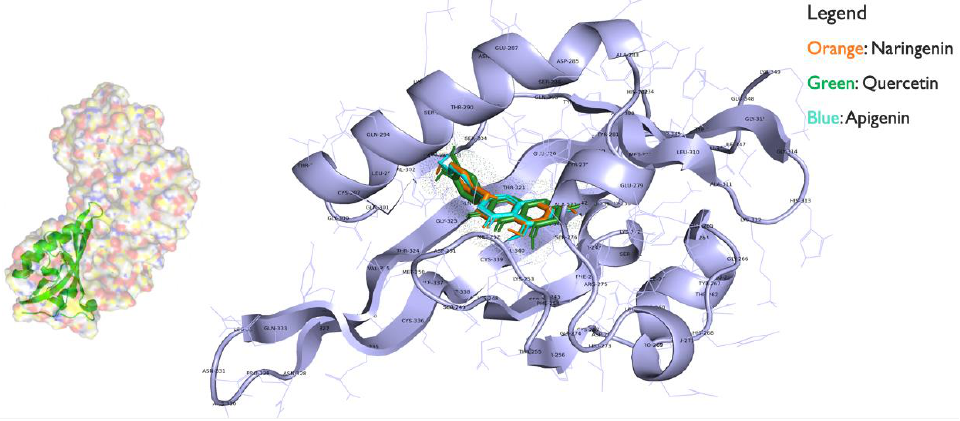
Figure 3. ( a ) HeLa cells imaged with TRITC filter. Twenty-four hours post-transfection with CYP1A1 prom ::mScarlet, LacZ, or no DNA, cells were treated with 0uM ( i , v , ix respectively), 100  M apigenin ( ii , vi , x respectively), 100  M naringenin ( iii , vii , xi respectively), or 100  M quercetin ( iv , viii , xii respectively) for twenty-four hours, washed, and imaged. ( b ) Fluorescence (Ex 560; Em 593) measured in HeLa cells transfected with CYP1A1 prom ::mScarlet or No DNA, treated with 0 µM, 100 µM apigenin, 100 µM naringenin, or 100 µM quercetin. Each bar represents an average of n = 3. Yellow bars show significant reduction in the average (  SD) fluorescence in the presence of apigenin, but not in other conditions, to the fluorescent level of untransfected cells (red bars; * represents p < 0.01).